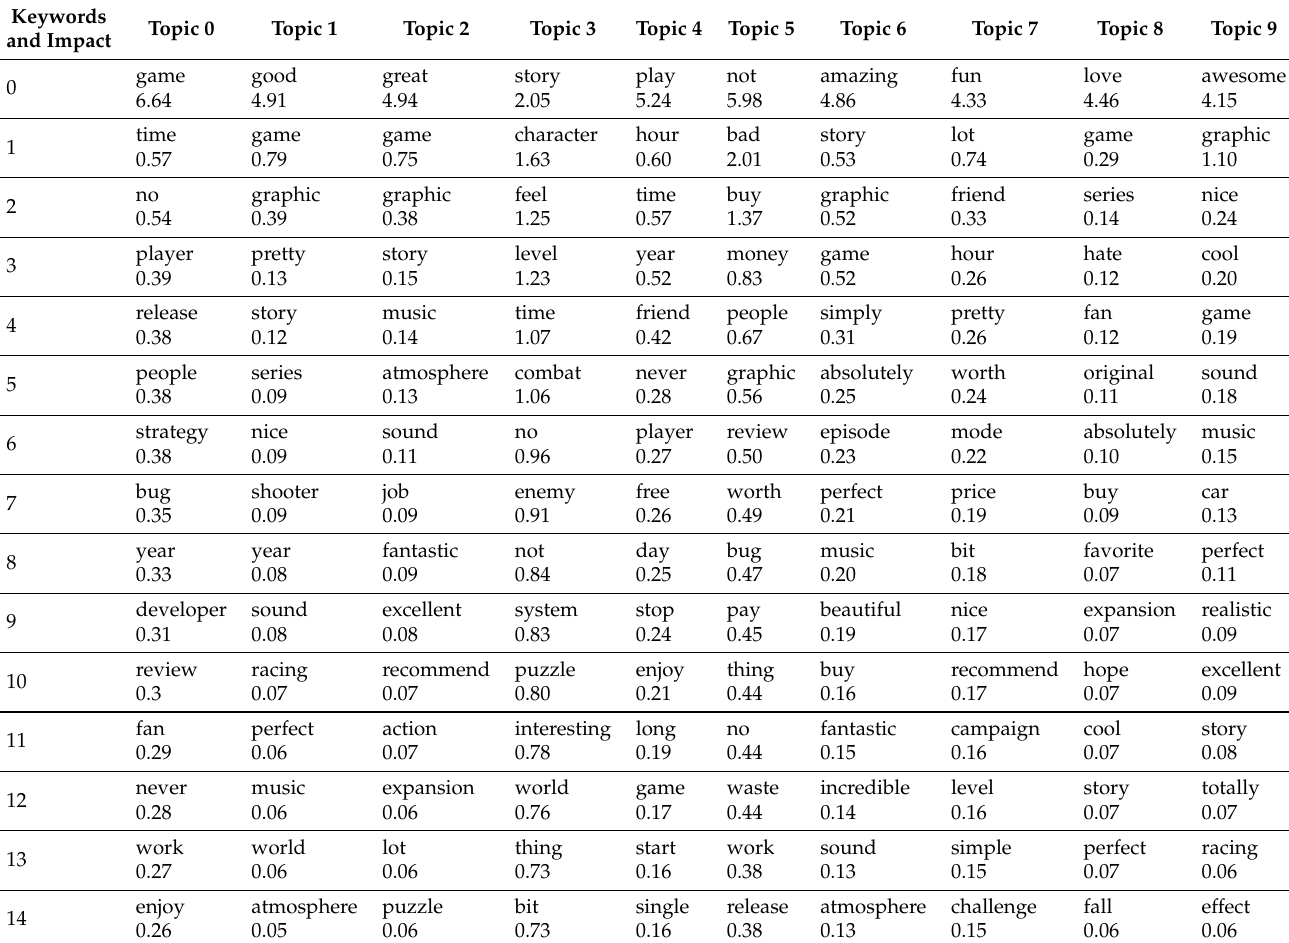
Table 4. The most relevant features for topics generated with